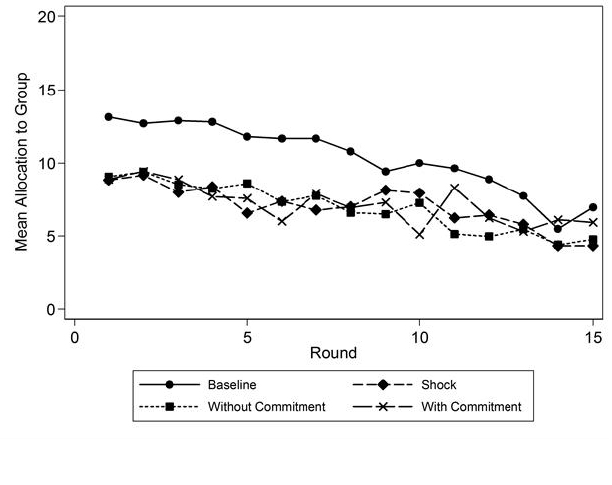
Fig. 2 . Mean individual allocation to the group